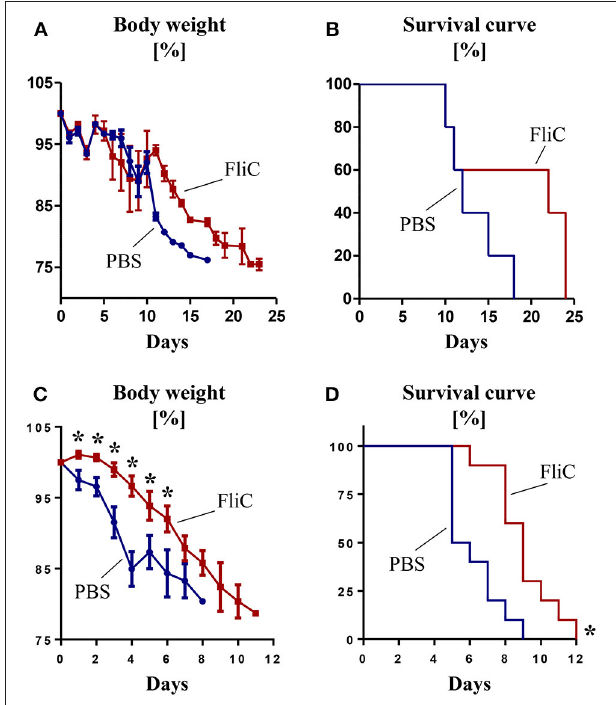
FIGURE 2 | Adaptive immunity to FliC protects mice from Salmonella infection. Six week old male WT mice were treated with FliC (50 µ g) on day 0 and 14, and infected with Salmonella typhimurium on day 21. (A) Percent body weight and (B) Kaplan–Meier survival curve for mice receiving oral infection (10 8 CFU bacteria; n = 10). (C) Percent body weight and (D) Kaplan-Meier survival curve for mice receiving intraperitoneal infection (10 4 CFU bacteria; n = 10). Results presented as mean ± SEM. Data (A–D) are pooled from two independent experiments. * p < 0.05 (Student’s t test) for (A,C) ; * p < 0.005 [Log-rank (Mantel-Cox) test] for (B,D)